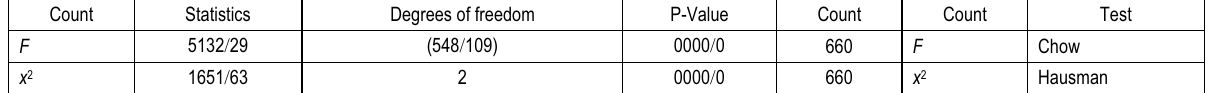
Table 3. Chow and Hausman test results for the model (1.3)